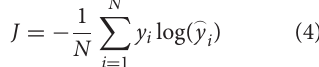
FIGURE 7 | CNN architecture of the gait classification